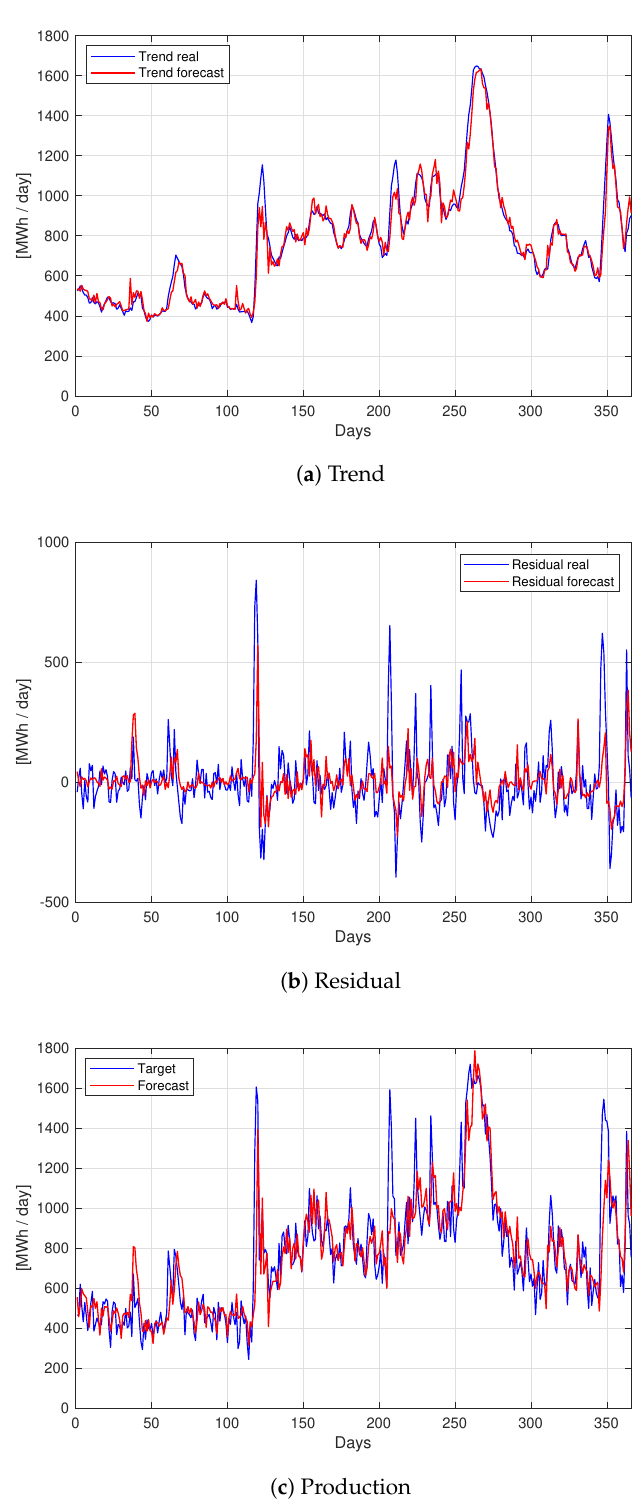
Figure 9. Comparison between forecast (red) and observed (blue) values in the decomposition phases: ( a ) Trend component; ( b ) Residual Component; ( c ) Recomposed production (Trend, Seasonality and